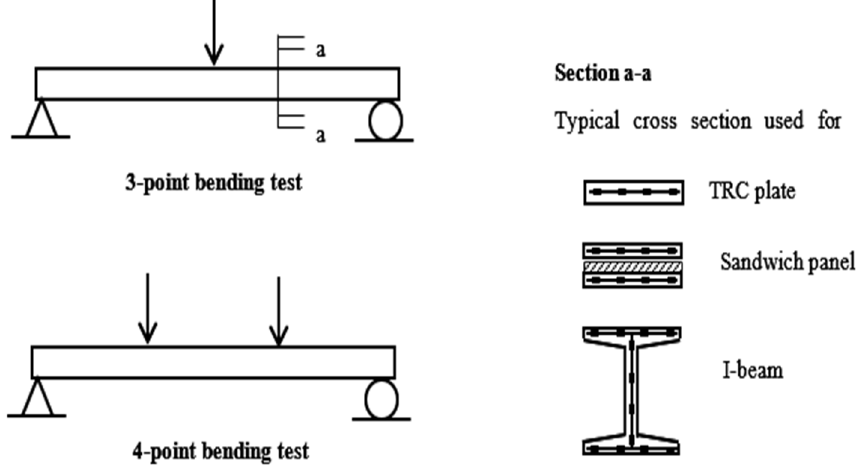
Figure 11. Bending test on a typical cross-section of TRC element.